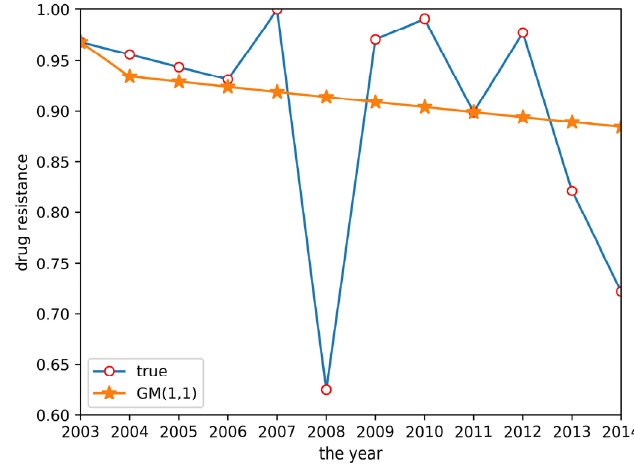
Figure 3. GM(1,1) prediction result.